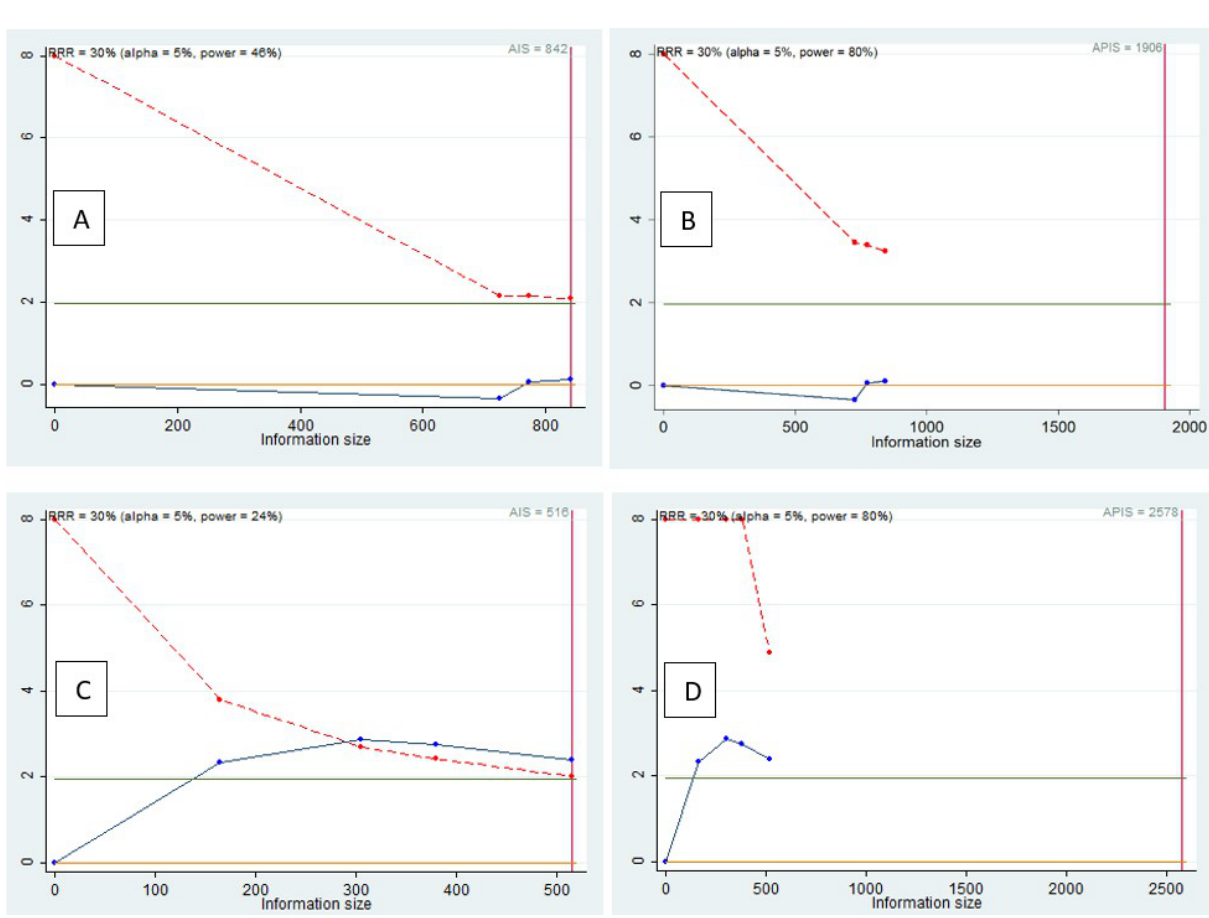
Figure 7. ( A , B ) Follow-up 1 year; ( C , D ) follow-up 2 year; light green line (Z = 1.98), dashed red line (monitoring boundary), blue line (cumulative z curve), red line (sample size). AIS (accrued information size ( A , C )); APIS (a priori information size ( B , D )).